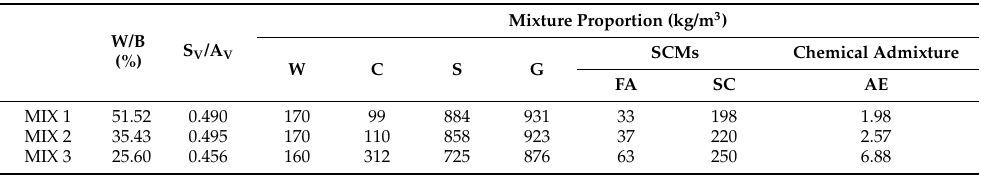
Table 1. Properties of the concrete cylinders used in this study.